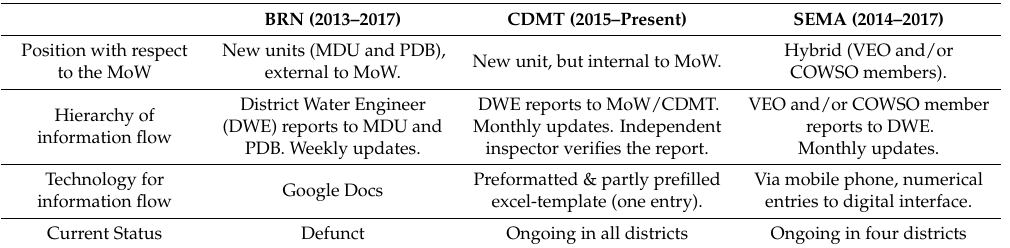
Table 1. Summary of three administrative technologies for the regular updating of WP